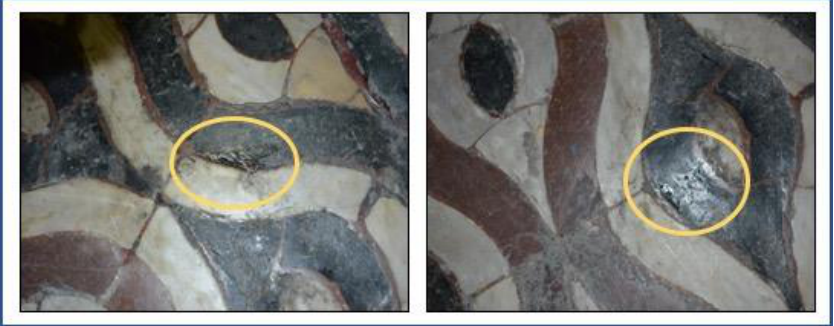
Figure 7. Detail of the baptistery pavement showing the water rising from the subsoil (yellow circles).